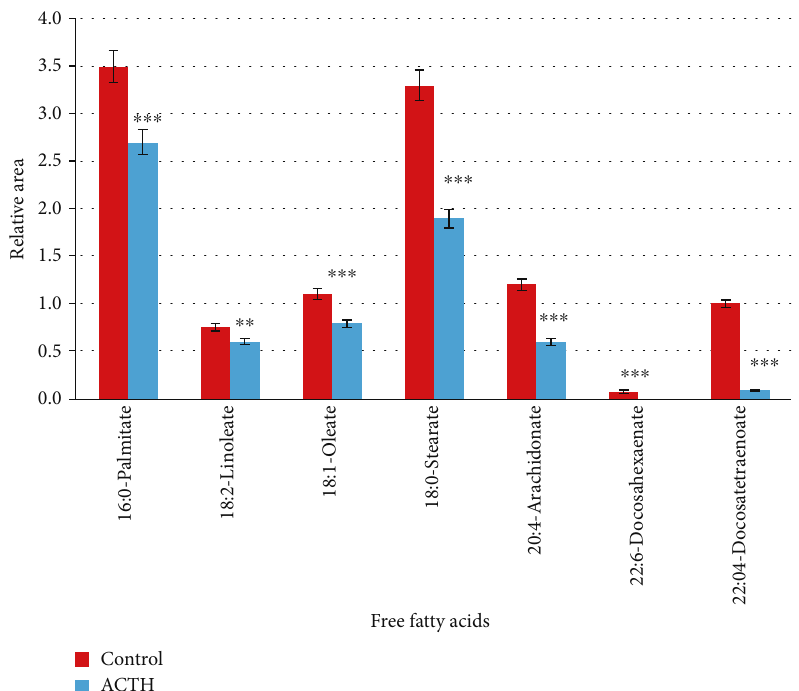
Figure 4: GC/MS results of free fatty acids extracted from the control and adrenocorticotropic hormone (ACTH) adrenals. Values are expressed as mean ± standard deviation . ∗∗∗ p < : 0001 and ∗∗ p < : 001 vs. control. p < : 05 was considered statistically signi fi